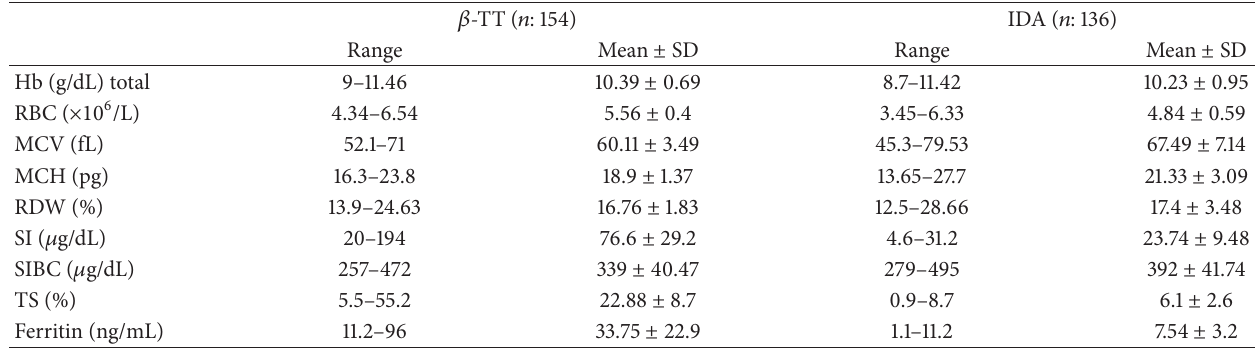
Table 1: Hematological and biochemical date of study